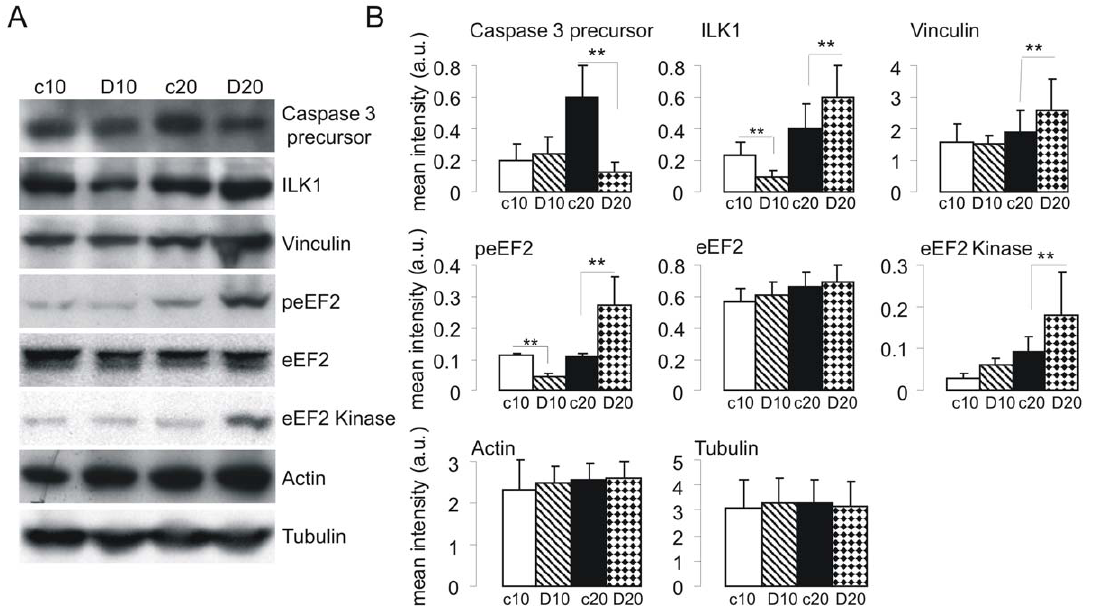
Figure 2. Immunoblotting validation of a set of proteins identified as being differentially expressed in glioblastomas treated with PF4-DLR. Tissue lysates of glioblastomas treated with PF4-DLR for 10 or 20 days (D10 and D20) or untreated (c10 and c20) were prepared as described in Materials and Methods, and the proteins were resolved on 6–12% PAGE gels. A) The proteins were blotted onto a nitrocellulose membrane and detected with antisera raised against the individual proteins indicated on the right side of each panel. B) Histograms of the mean band intensity ( 6 SEM) of each protein. *p , 0.05, t test.